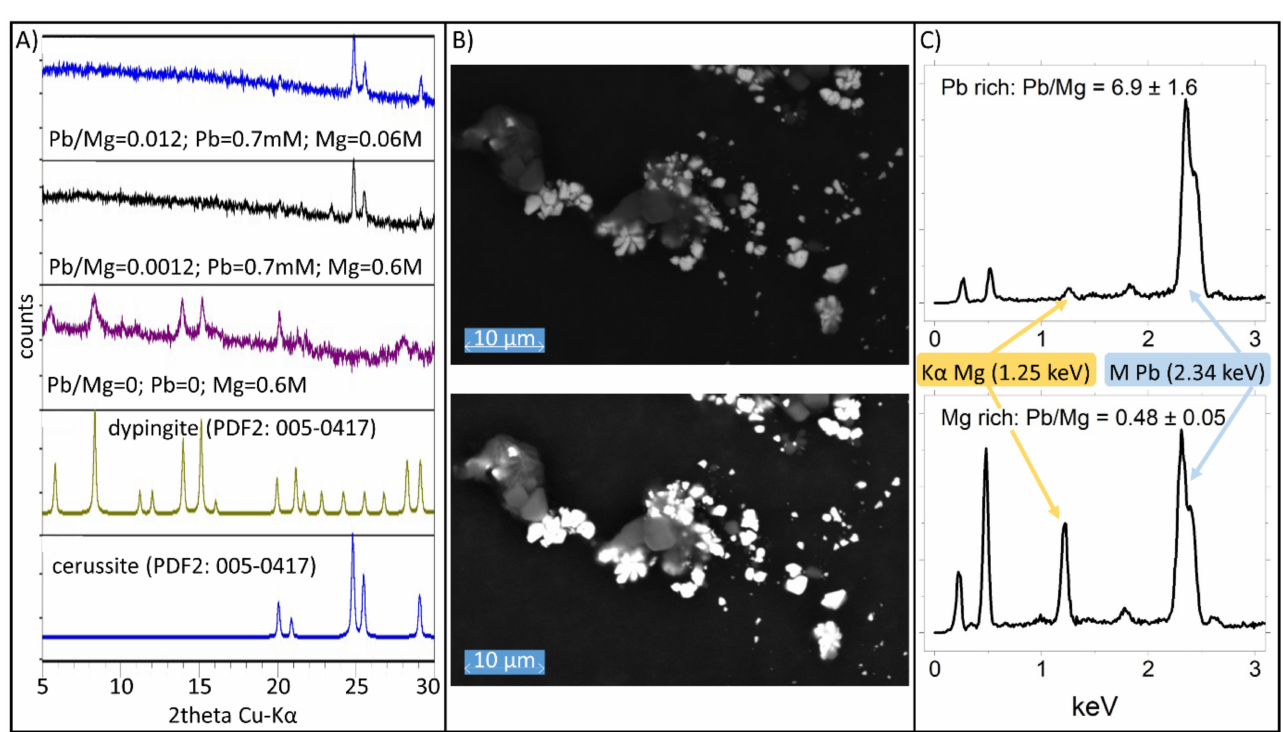
Figure 4. ( A ) X-ray diffraction of the precipitation products shows that cerussite is the only detectable phase in presence of Pb. Pb free experiments show the formation of dypingite as crystalline phase. The high background to signal ratio suggests the formation of solid with low crystallinity. ( B ) SEM micrographs show the presence of two phases during the coprecipitation of Mg and Pb carbonates. The images reported were collected with backscattered electron on the same area. Two different brightness-contrast settings are used to allow the visualization of the Pb-rich (bright) and Mg-rich (dark) phases due to the elevated difference in the atomic weight. ( C ) EDX analysis confirms the presence of two different phases characterized by a different Pb/Mg